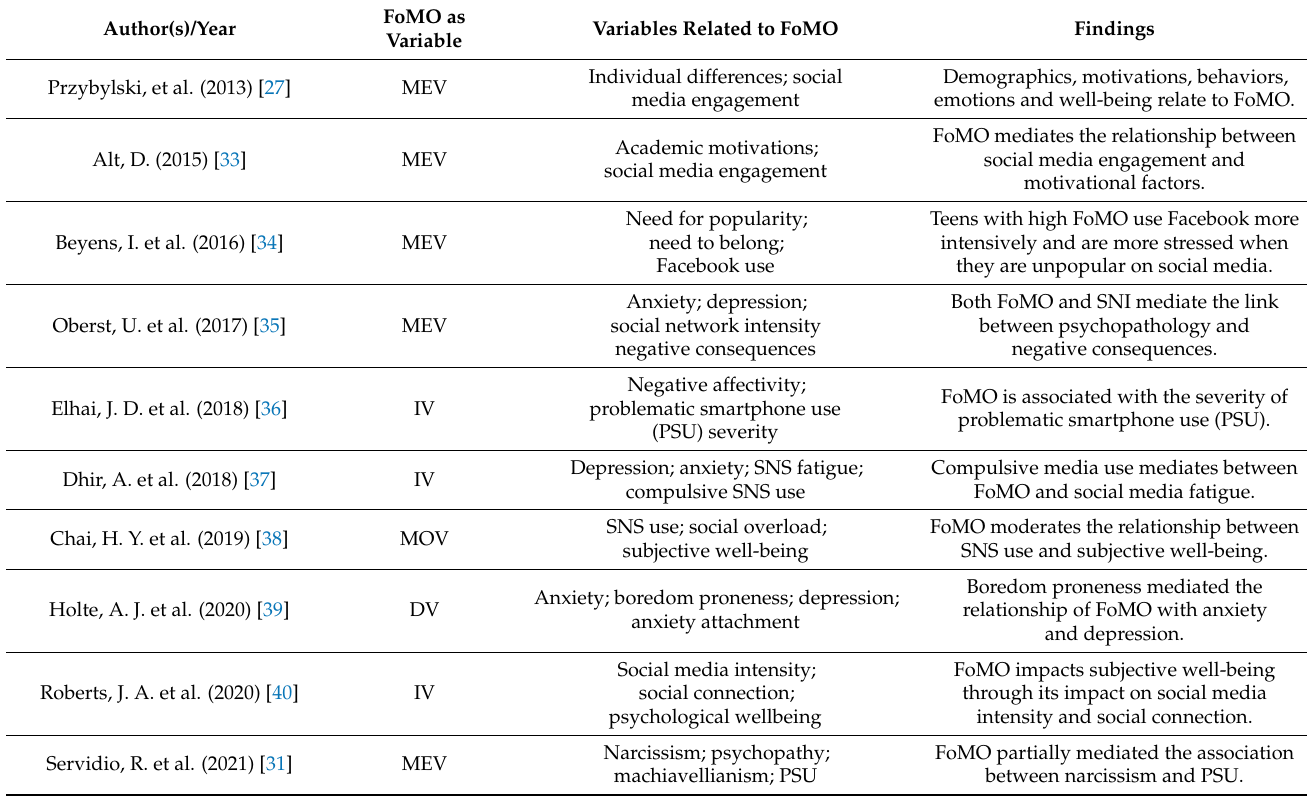
Table 1. Representative literature of FoMO-related